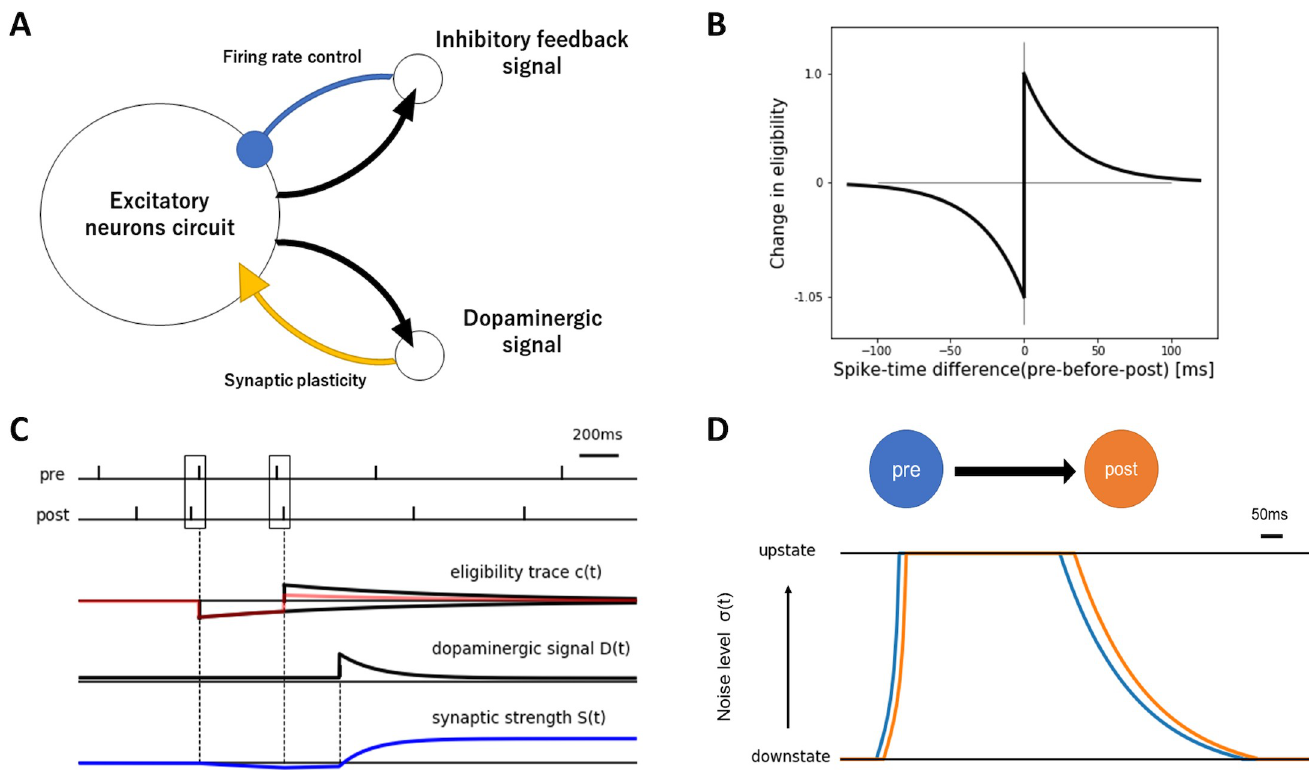
Fig 1. Schematic explanation of the modified reward-modulated STDP rule. (A) The whole network overview. (B) The STDP learning window. (C) The mechanism of synaptic plasticity. Synaptic weight changes as a product of eligible trace c ( t ) and dopaminergic signal D ( t ). (D) The upstate propagation from a presynaptic neuron to a postsynaptic